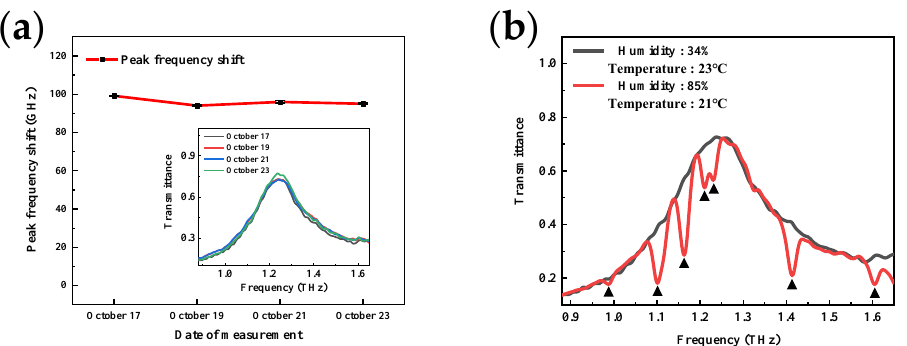
Figure 11. Sensing test stability characterization: ( a ) The long-term durability of fabricated sensors; ( b ) The effect of humidity environment on the device.